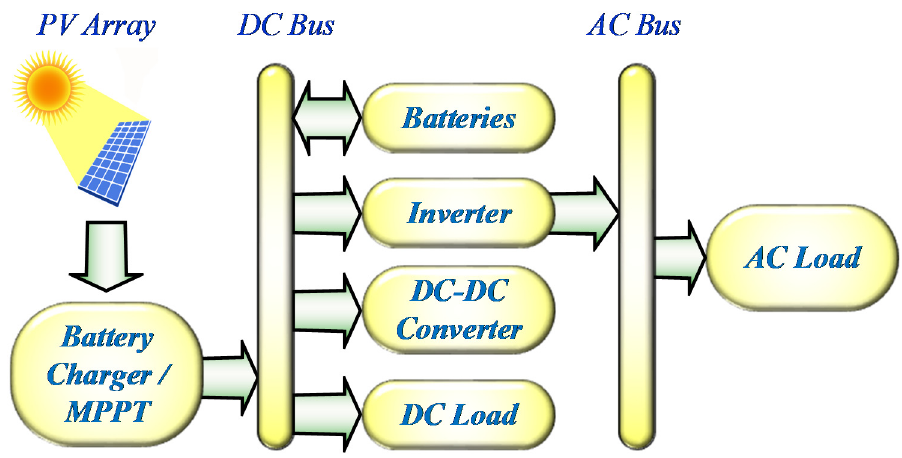
Figure 2. Block diagram of standalone photovoltaic (PV) system.